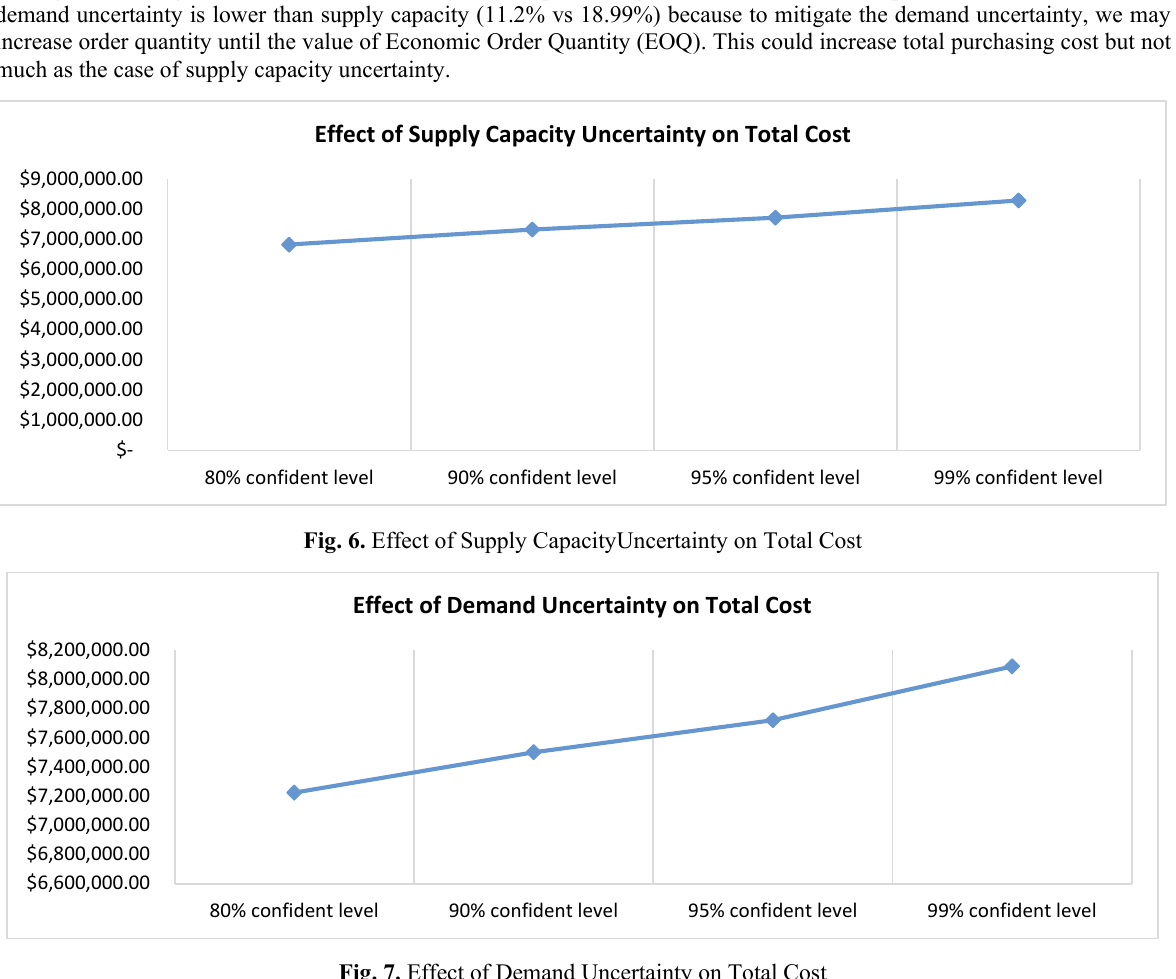
Fig. 7. Effect of Demand Uncertainty on Total